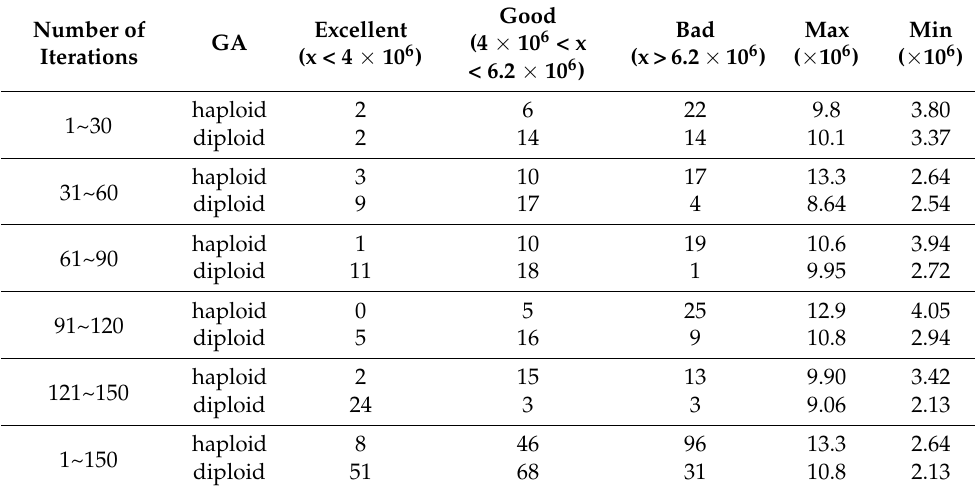
Figure 12. In the process of algorithm optimization, there is expected to be abnormal membership function. In this case, the algorithm will correct the non-compliance with the membership function